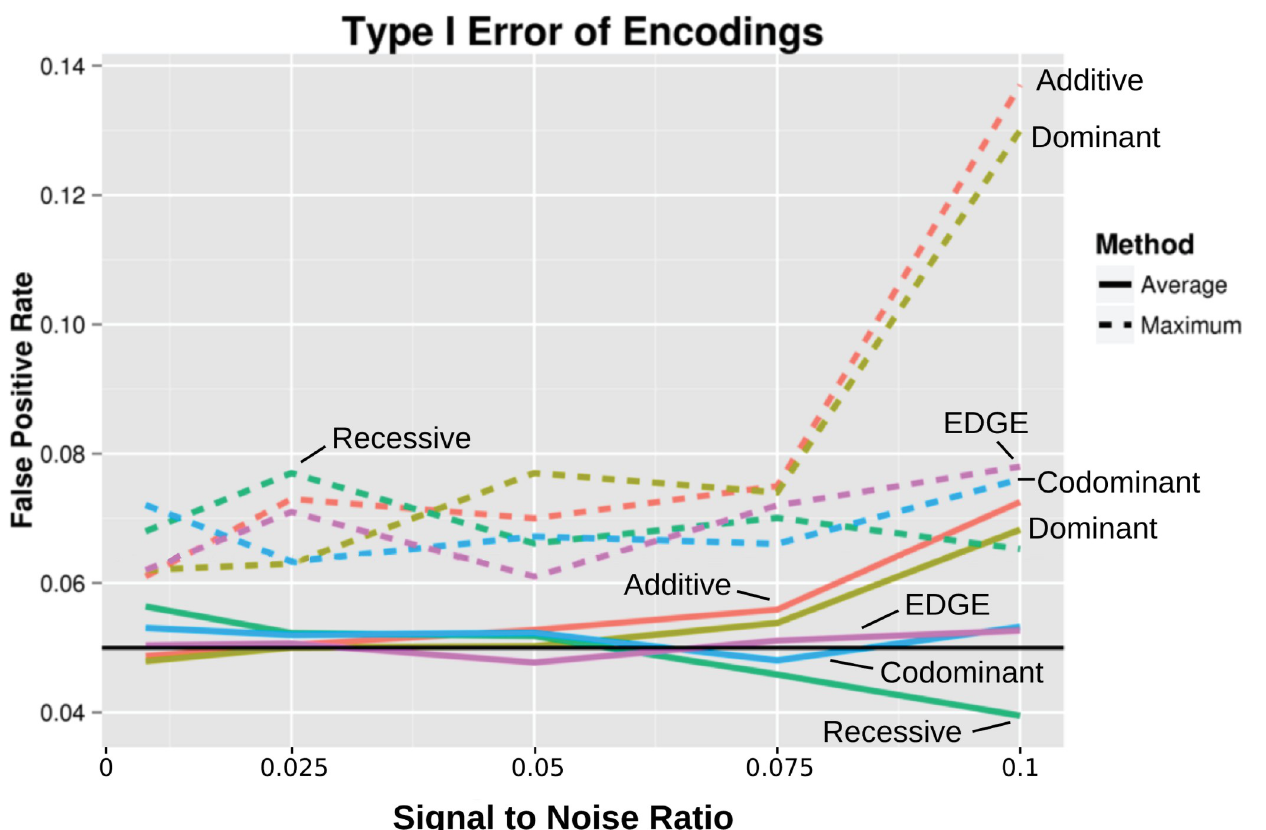
Fig 3. Average and maximum type I error across all main effect and null simulated datasets. Average false positive rates (solid lines) and the false positive rate for the maximum inflated model (dashed lines) were calculated for standardized signal to noise ratios. Values are plotted at increasing signal to noise ratios for each encoding: additive (red), dominant (yellow), recessive (green), codominant (blue), and EDGE (purple). The black line denotes a 5% false positive